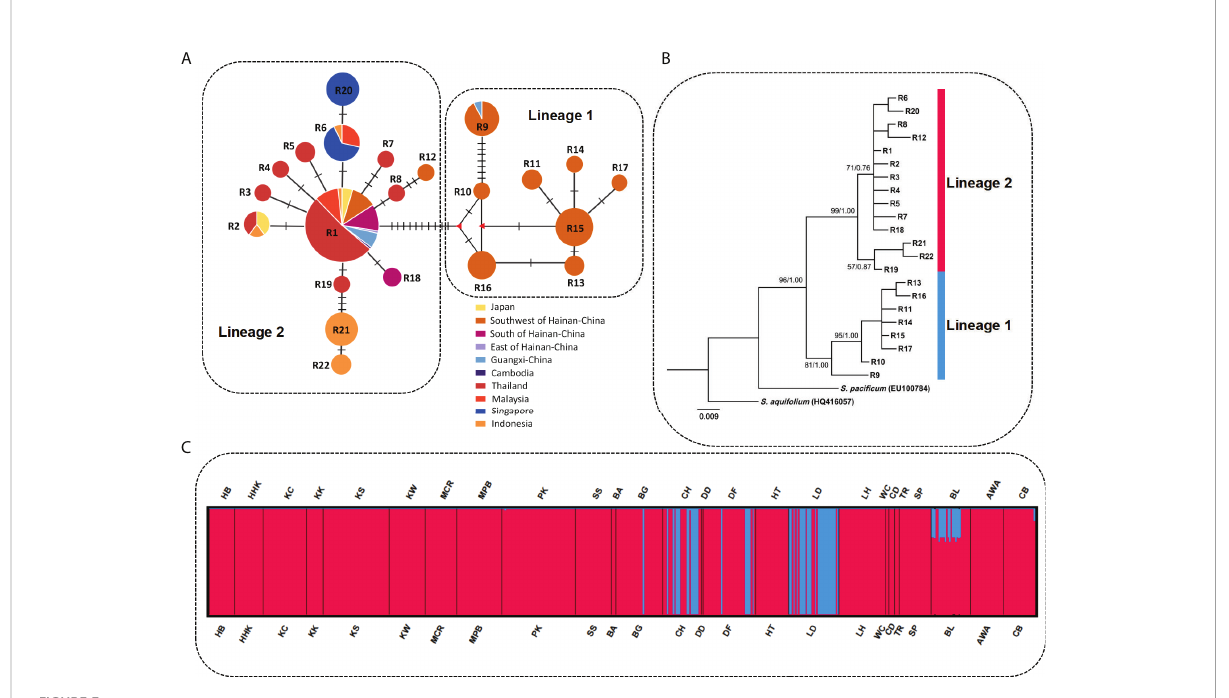
FIGURE 3 Parsimony median-joining network, phylogenetic relationships among ribotypes, and STRUCTURE analysis of S. polycystum inferred from nuclear ITS2. (A) Median-joining network of nuclear ITS2 ribotypes. Circle size is proportional to the population sample size. Each crossbar between ribotypes represents one mutation step, and different colors indicate different regions. Small red triangles indicate extinct or unsampledribotypes. (B) Maximum likelihood (ML) tree of S. polycystum based on nuclear ITS2 ribotypes. Node values are bootstrap supports (left) and BI posterior probabilities (right). (C) STRUCTURE analysis results based on nuclear ITS2 for S. polycystum at K = 2. Population codes are the same as in Table 1.